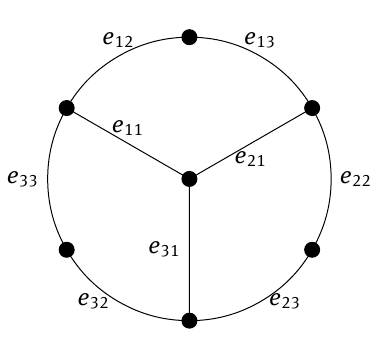
Fig. 1. The graph J